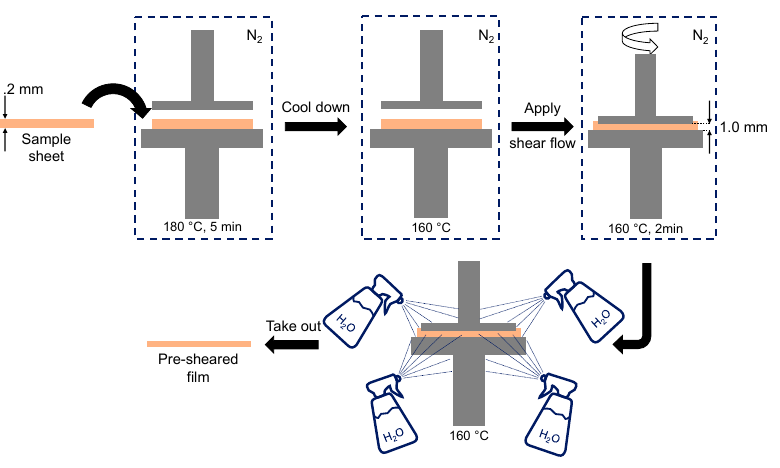
Figure 1. Illustration of the sample preparation method.